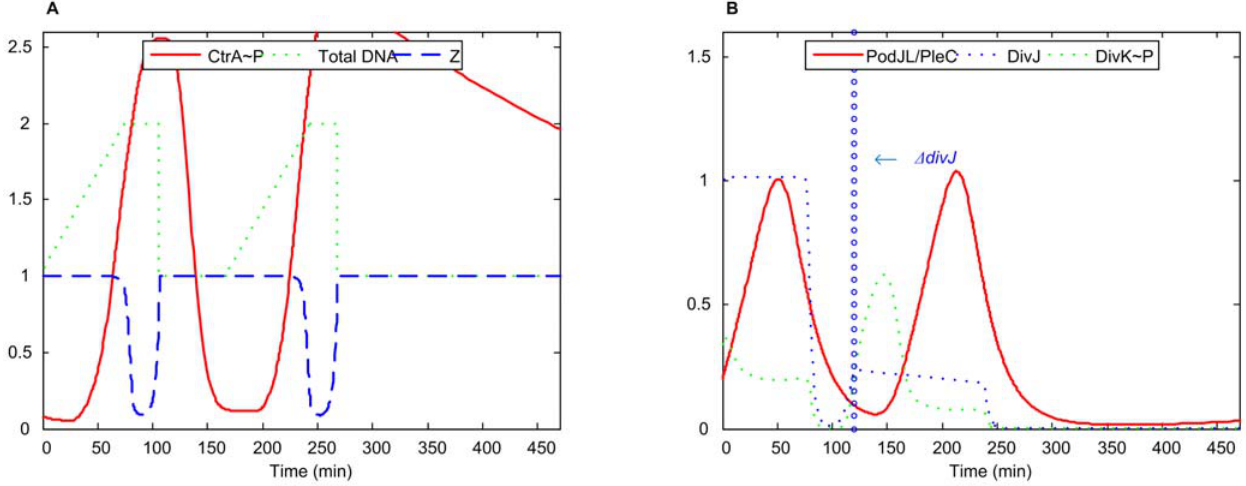
PLoS Computational Biology |